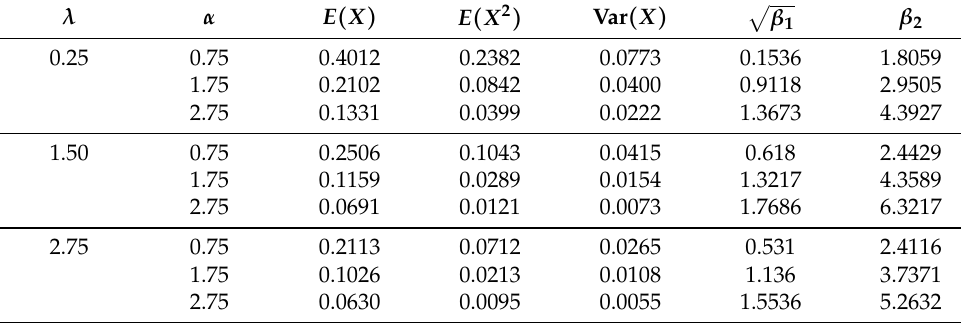
Table 1. Moments for a random variable with UPSN